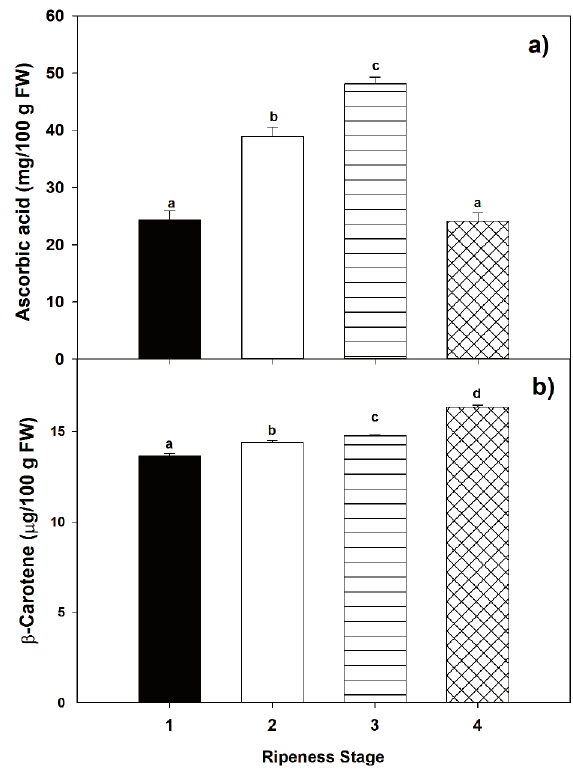
Fig. 1: Changes in ascorbic acid (a) and β-carotene (b) concentration in pineapple cv. Esmeralda at four ripening stages (RS). Different let- ters indicate significant differences (p < 0.05), n